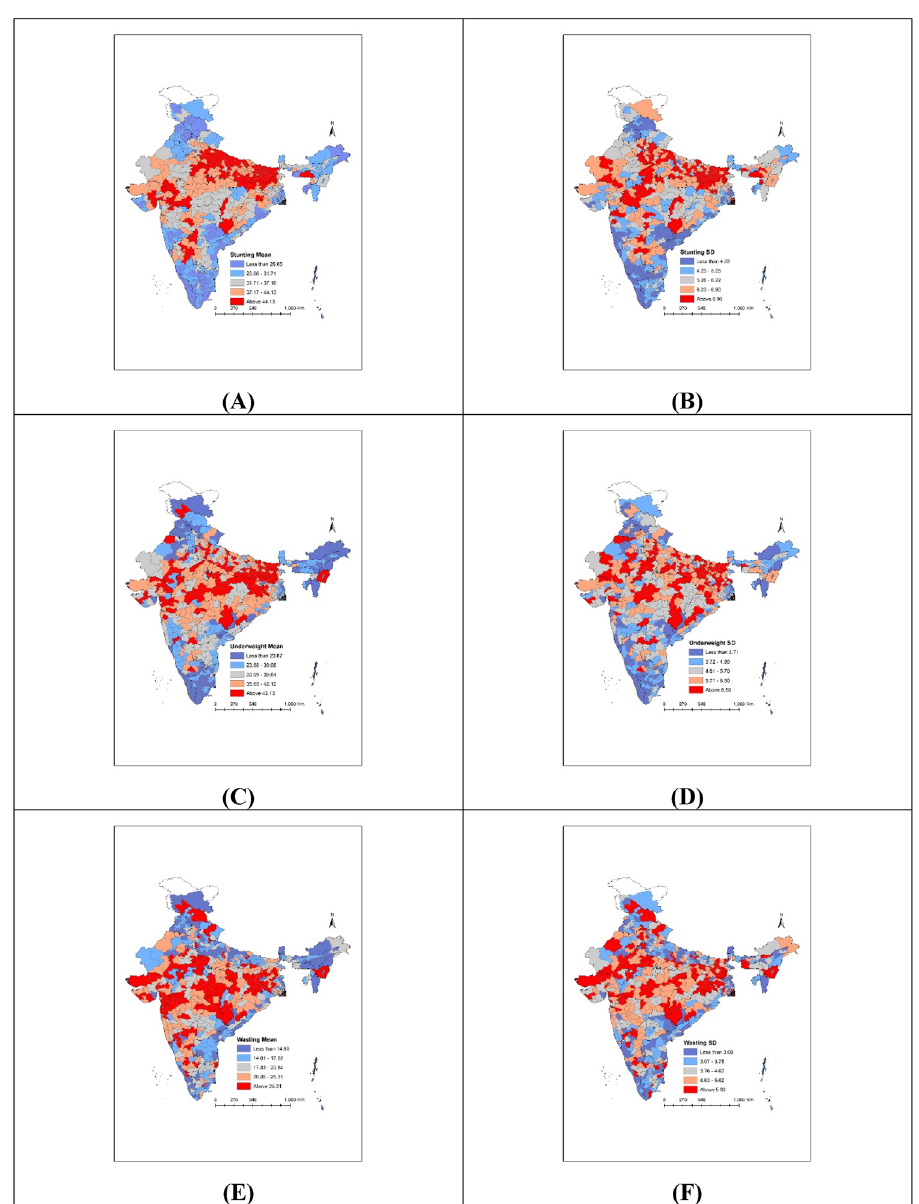
Figure 4. Maps showing geographic distribution of mean prevalence and SDs in child anthropometric failures across PCs for ( A ) stunting—mean; ( B ) stunting—SD; ( C ) underweight—mean; ( D ) underweight—SD; ( E ) wasting—mean; ( F ) wasting—SD. Note : Figures were generated using the spatial join tools in ArcGIS Desktop 10.6 (http://deskt op.arcgi s.com/en/arcma p/lates t/tools /analy sis-toolb ox/spati